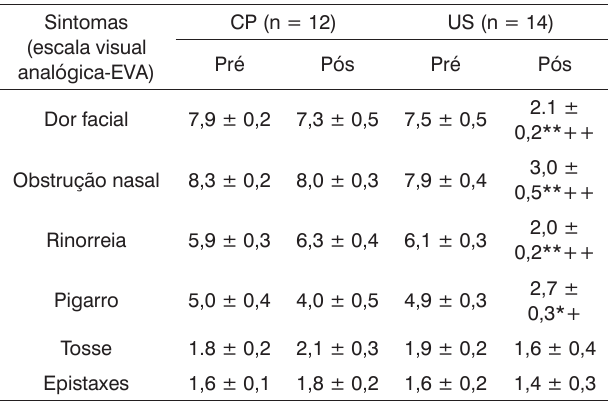
Tabela 2. Avaliação dos principais sintomas da rinossinusite crônica (RNC) antes e após única intervenção com ultrassom de 1-MHZ (US) ou placebo (CP) nos grupos experimentais.